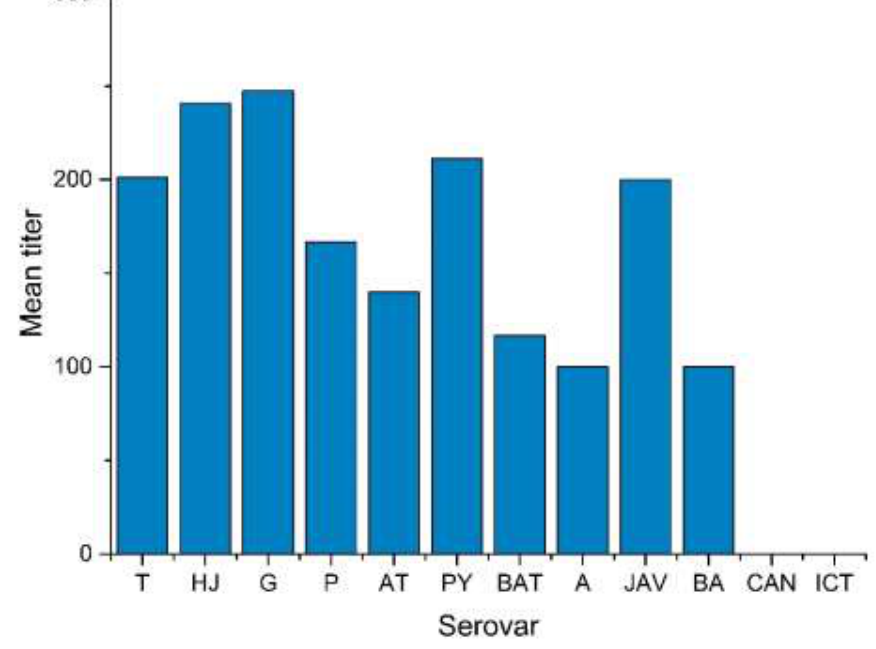
Figure 3. Mean titer of each serovar. Serovars included in the test: L. Tarassovi (T), L. Hardjo (HJ), L. Grippotyphosa (G), L. Pomona (P), L. Autumnalis (AT), L. Pyrogenes (PY), L. Bataviae (BAT), L. Australis (A), L. Javanica (JAV), L. Ballum (BA), L. Canicola (CAN) and L. Icterohaemorrhagiae